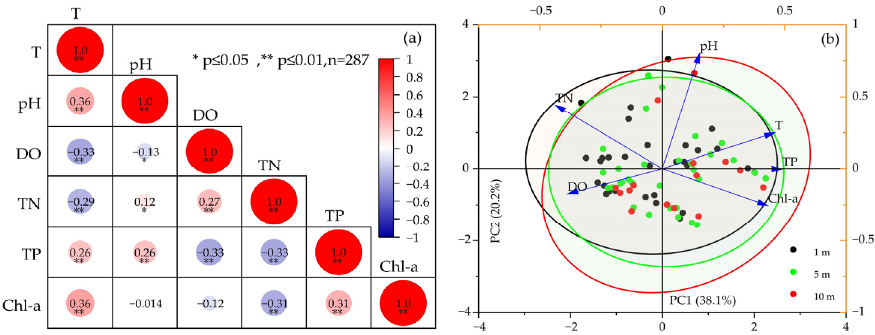
Figure 8. Correlation ( a ) and principal component ( b ) analysis of six water quality parameters.